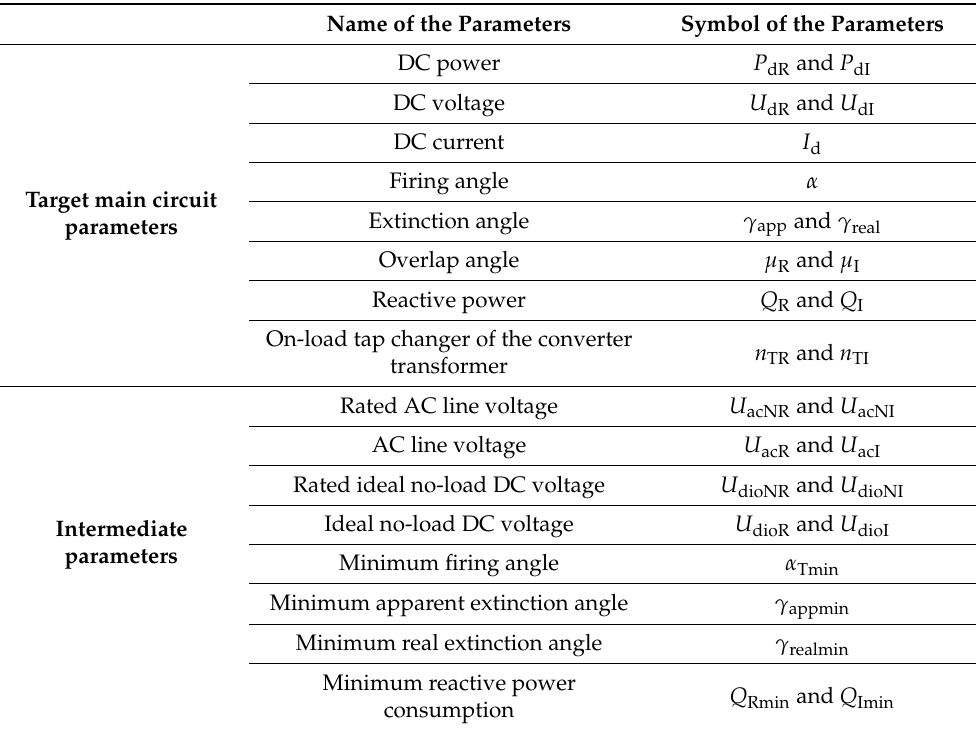
Table 2. The summary of the parameters during the calculation